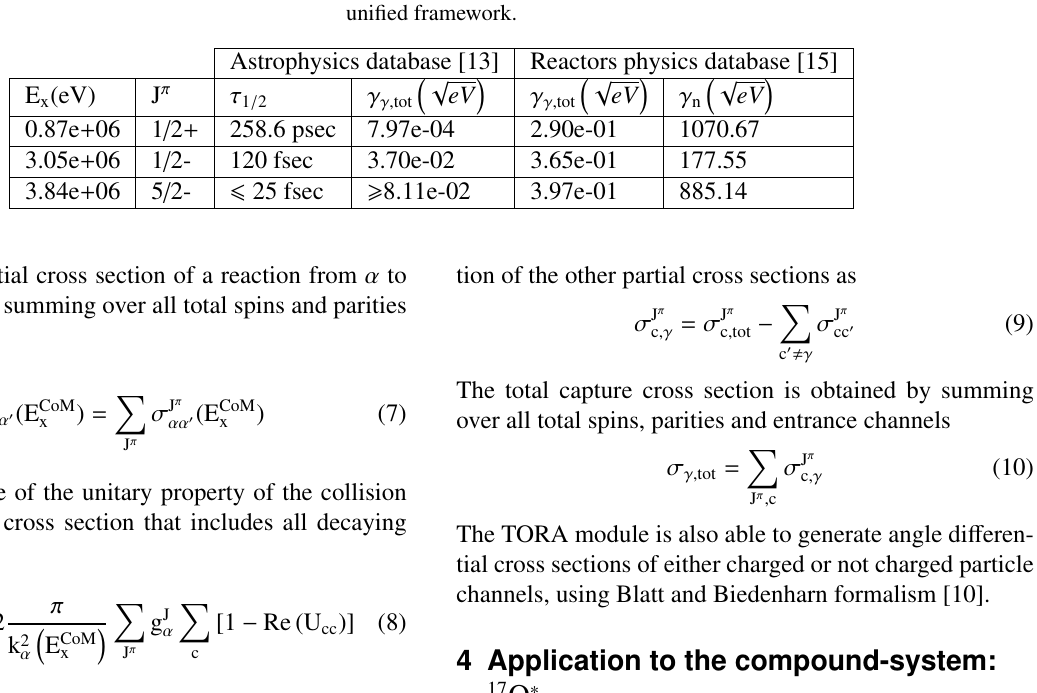
Figure 1. Partial and total cross sections of the 17 O ∗ system reconstructed within the unified framework from the JEFF33.T3 file parameters. The TORA results are compared to the experimental data presented in the references [16–24] . For better display, only the (n, γ ) calculation by TORA is drawn on this picture.